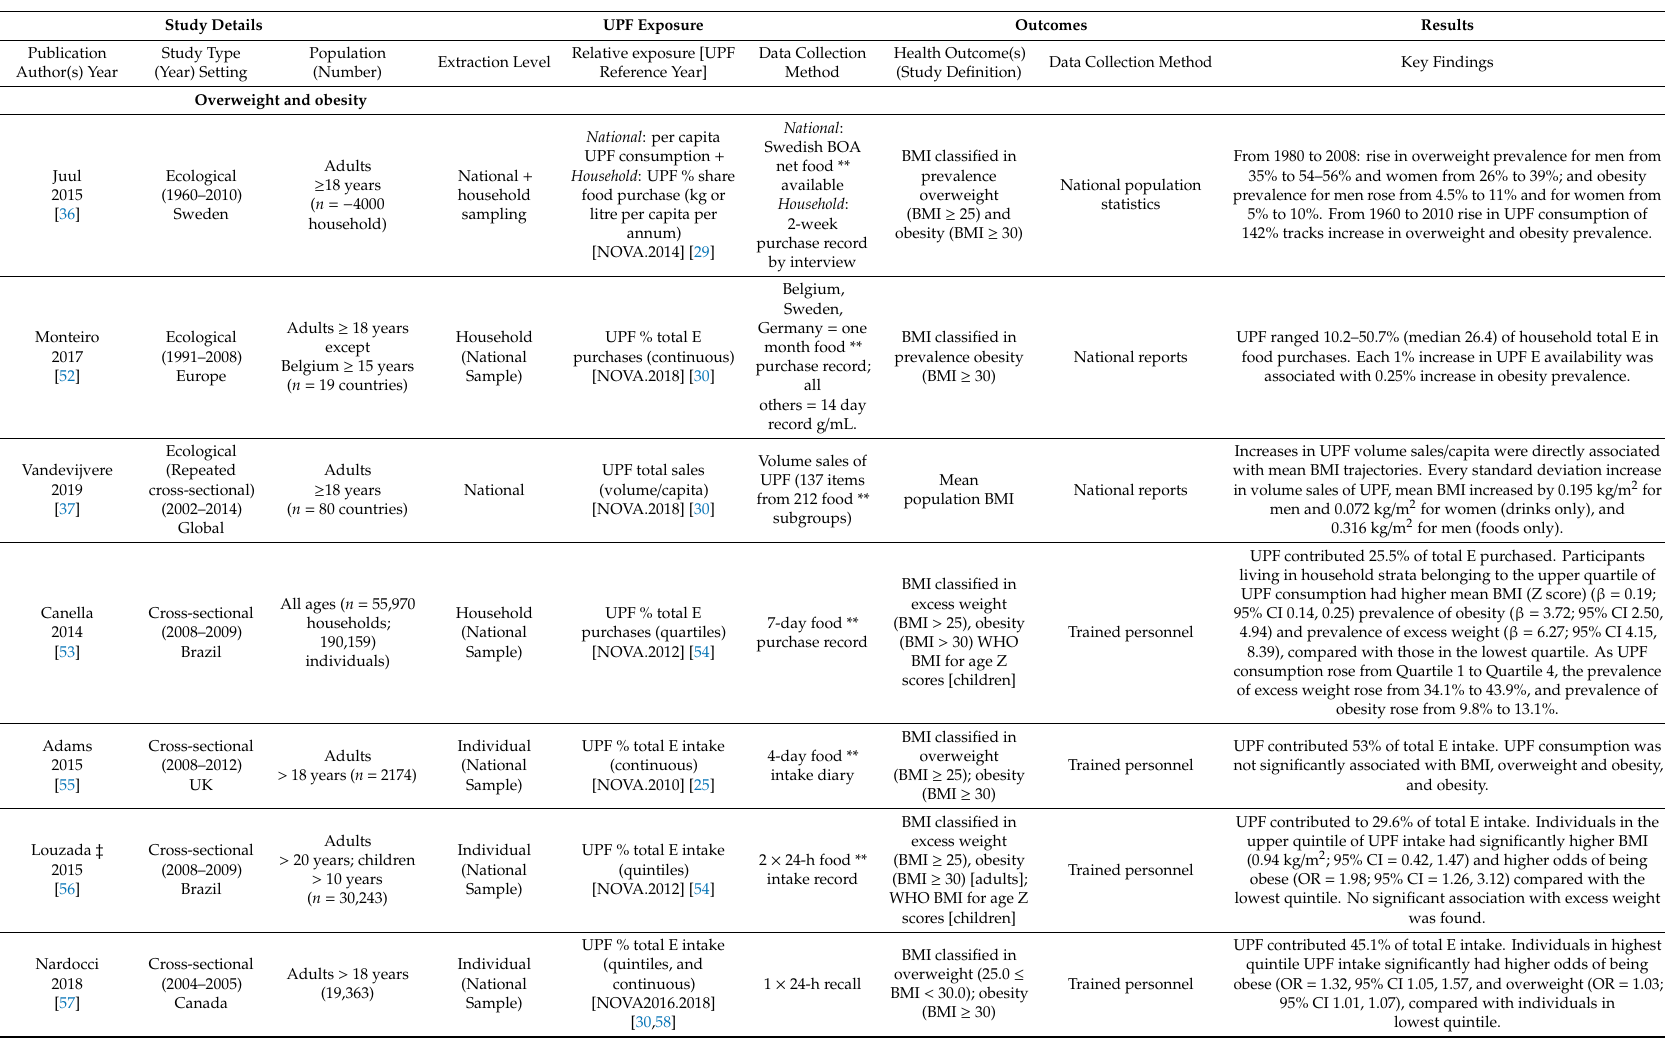
Table 2. Overweight, obesity and cardio-metabolic risks as outcomes in studies in adults